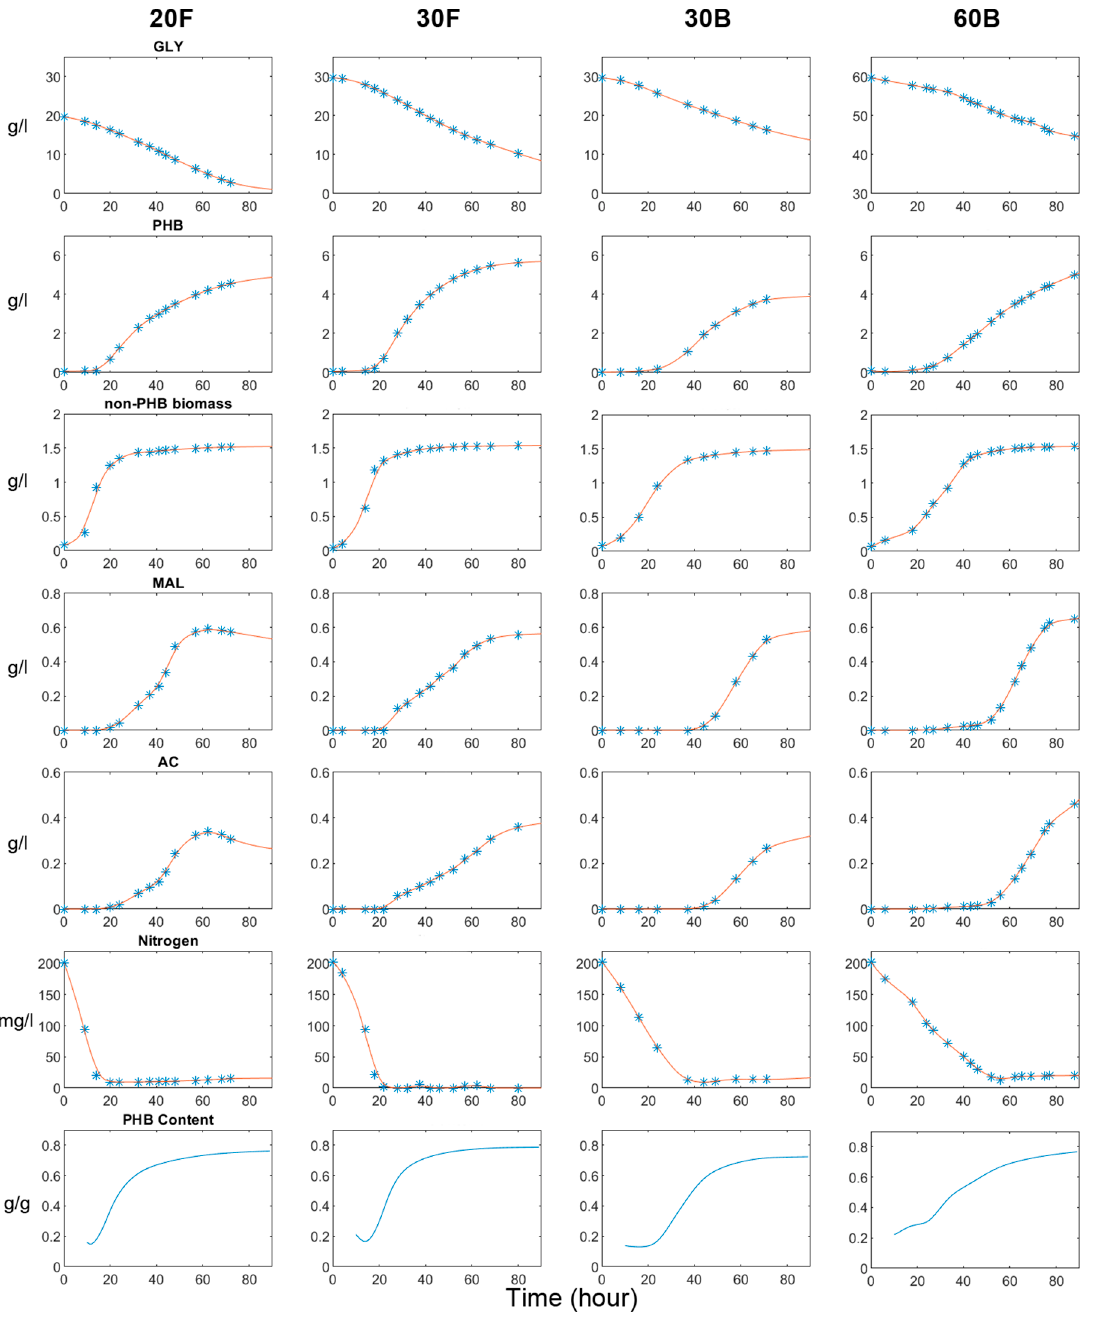
Figure 2. Measured experimental data (*) and smooth concentration profiles (line) of glycerol, poly(3-hydroxybutyric acid) (PHB), non-PHB biomass, acetic acid and malic acid for experiment 20F, 30F, 30B and 60B.